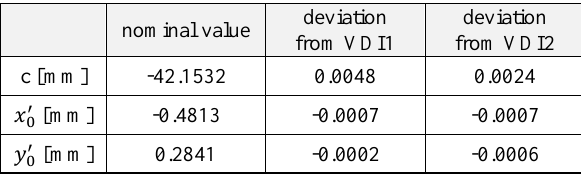
Values for principal distance and principal point of simultaneous calibration of set I (nominal value) and deviations from the nominal value of VDI calibrations for the ALPA 12 FPS add|metric in